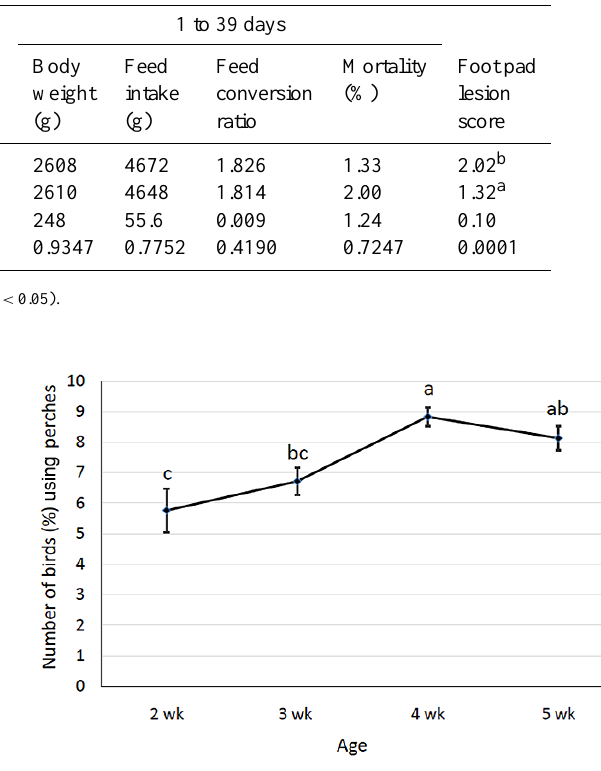
Figure 2. Perching ratio of broilers chickens throughout advancing age. Data are means of three replicates that each contained 50 birds per pen. Means having different letter differ ( P <